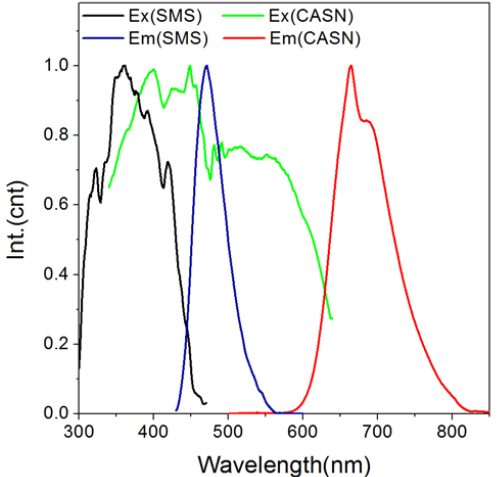
Figure 2. Photoluminescence excitation/emission spectra of the as-synthesized SMS and CASN nanoparticles, respectively. The excitation spectra of SMS and CASN were monitored at 470 nm and 665 nm, respectively. The emission spectra of SMS and CASN were excited at 400 nm and 470 nm, respectively.